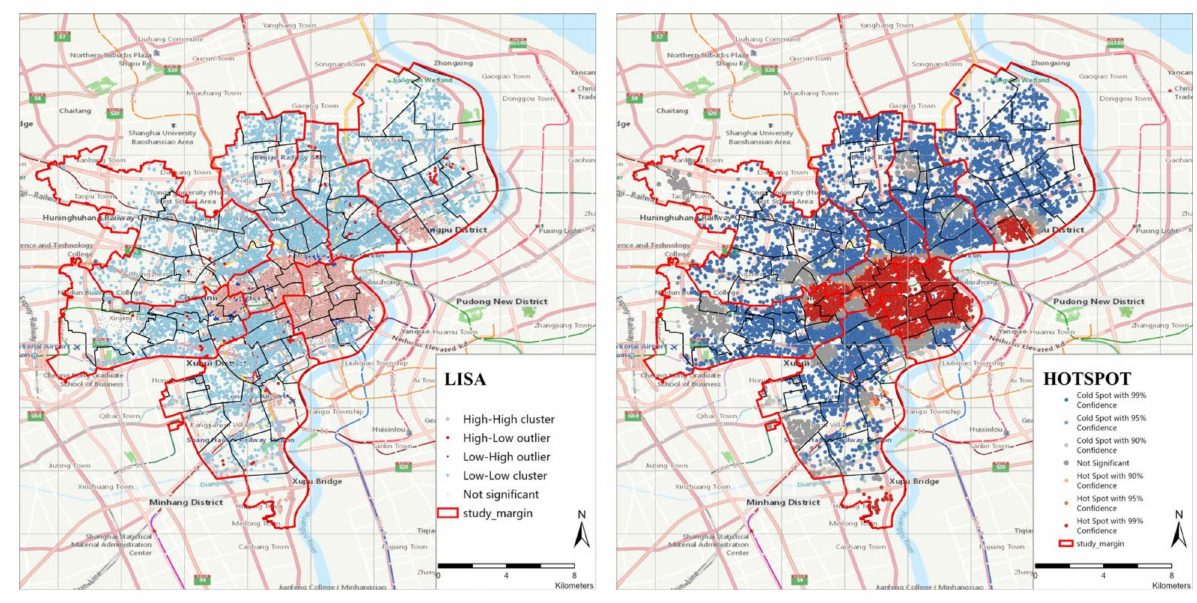
Figure 9. Local autocorrelation analysis of Category − I (LISA, Getis-Ord